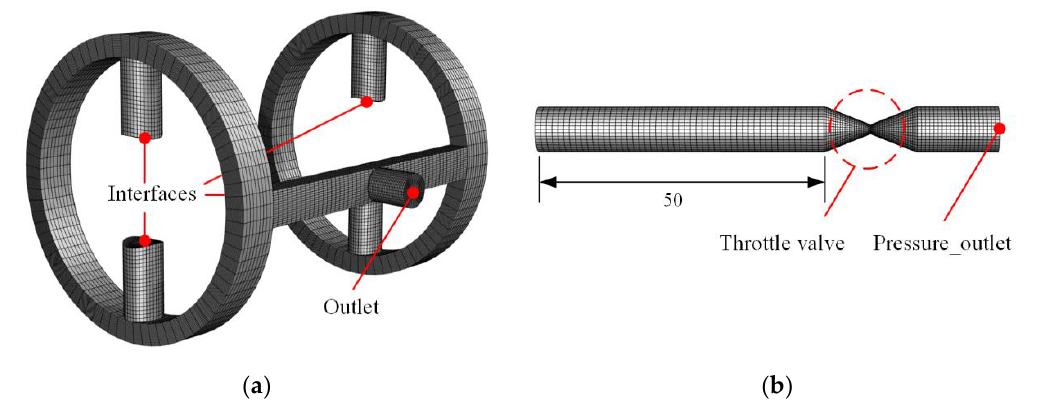
Figure 7. ( a ) The outlet fluid zone and ( b ) the outlet pipe.